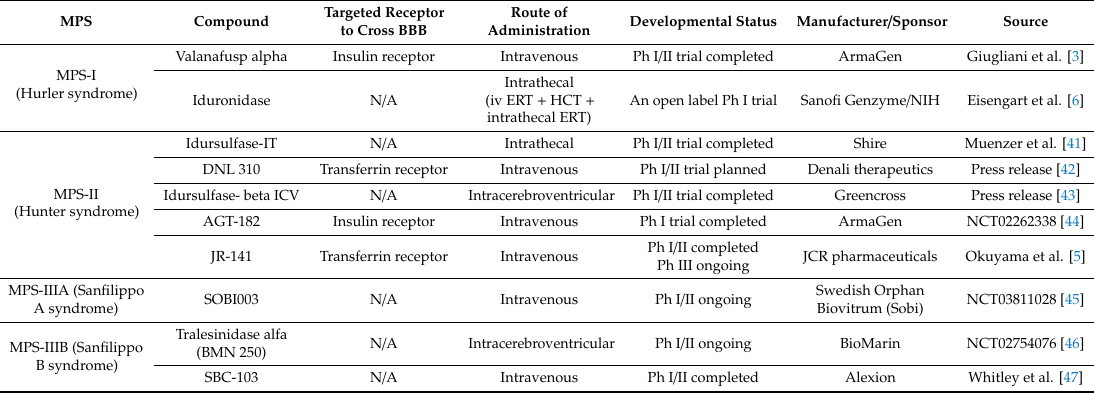
Table 2. Hitherto attempted enzyme replacement therapies targeting CNS pathology in MPS. ERT, enzyme replacement